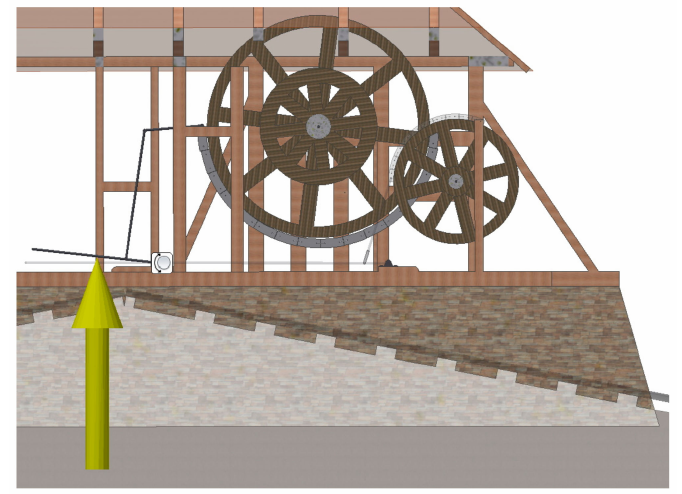
Figure 13. Force exerted on the braking bar in the situation of emergency